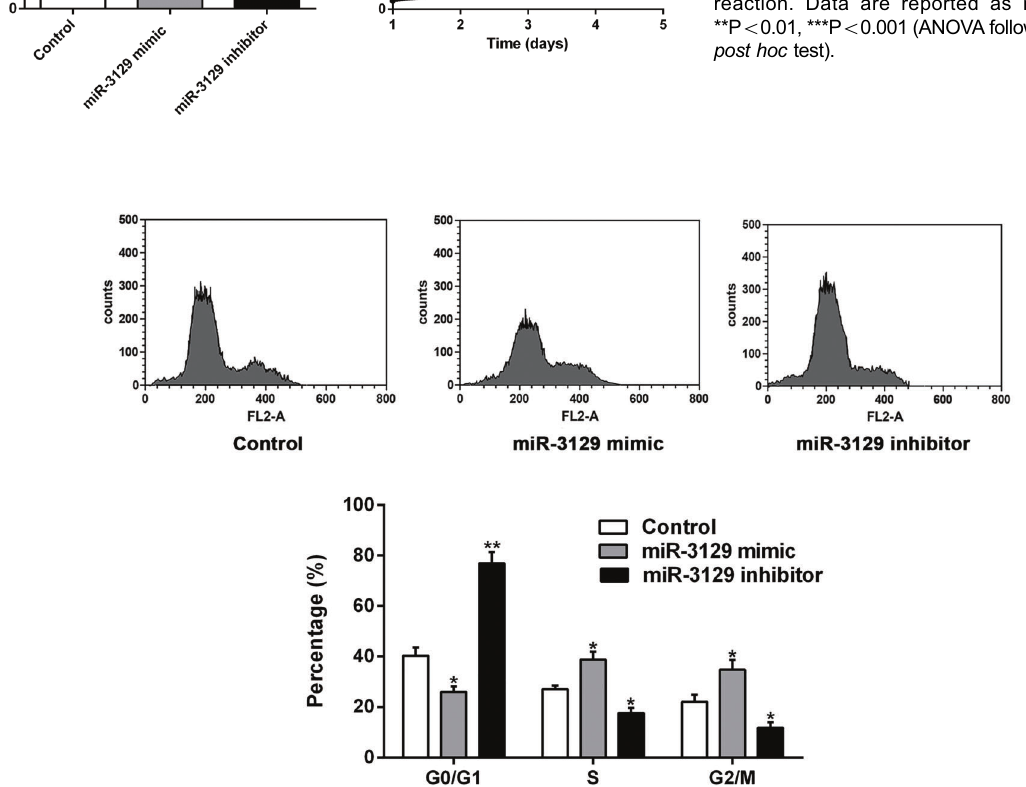
Figure 3. Effect of miR-3129 on gastric cancer cell cycle. After transfection with miR-3129 mimic and inhibitor, the percentage of cells in G1/G0, S, and G2/M phases was analyzed by fl ow cytometry. Data are reported as means ± SD. *P o 0.05, **P o 0.01 (ANOVA followed by Tukey post hoc